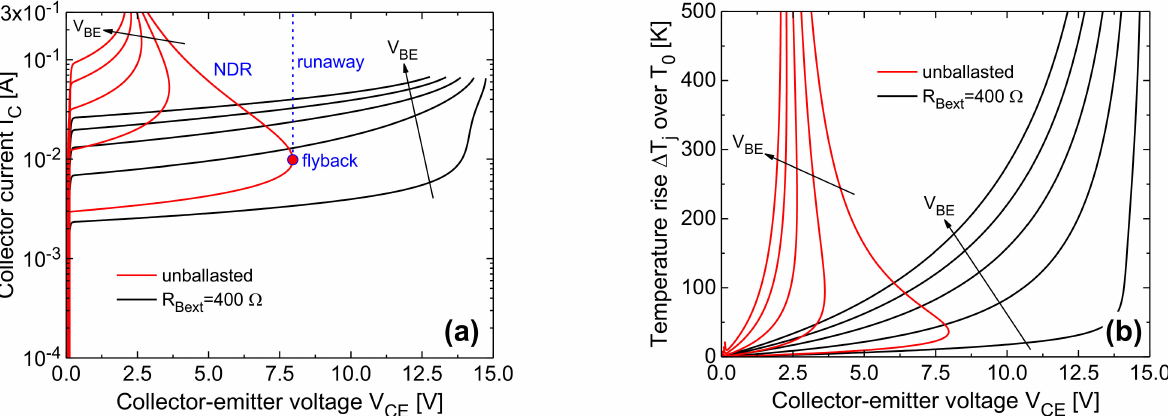
Figure 11. Test device with single unit cell: simulated ( a ) collector current I C and ( b ) corresponding temperature rise ∆ T j above T 0 against collector-emitter voltage V CE for V BE = 1.25, 1.3, 1.35, 1.4, 1.45 V. The unballasted case (red lines) is compared to the one with R Bext = 400 Ω connected to the base